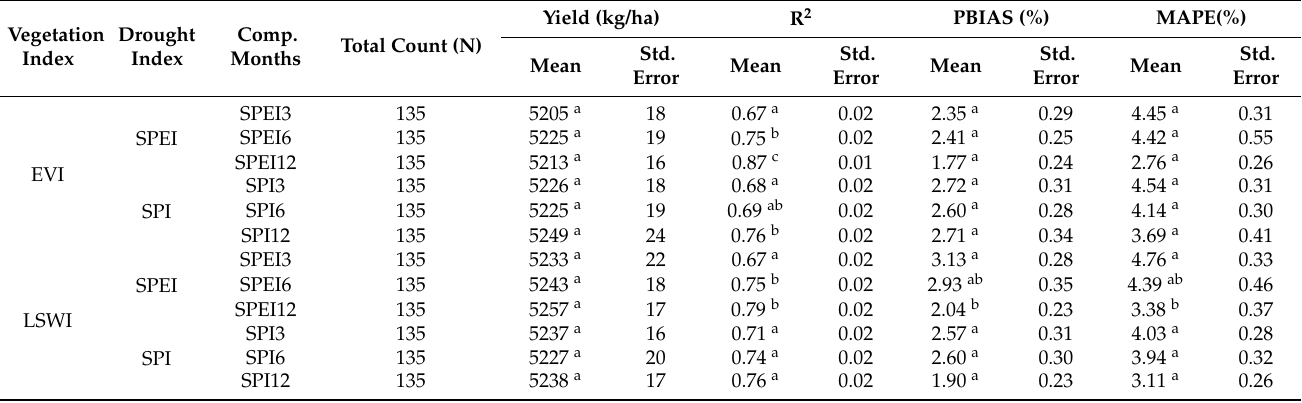
Figure 4. Exceedance probability curves of computed R 2 and PBIAS values for annual cotton yield predicted by ANN using eighteen combinations of drought indices computed at 3, 6, and 12 months and vegetation indices. Table 2. Descriptive statistics and ANOVA results of predicted cotton yield and computed model prediction performance measure values for various CP-CHUs-DI-VI